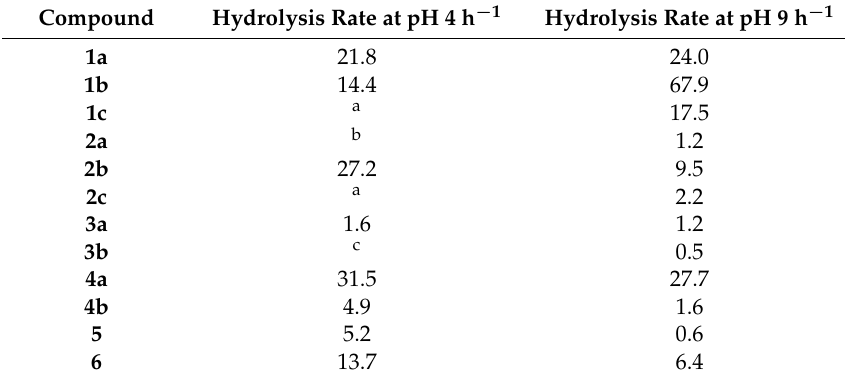
Table 4. Hydrolysis of the silanes in Figure 6 in acidic and alkaline media. Reprinted with permission from [46]. Copyright Springer Nature,